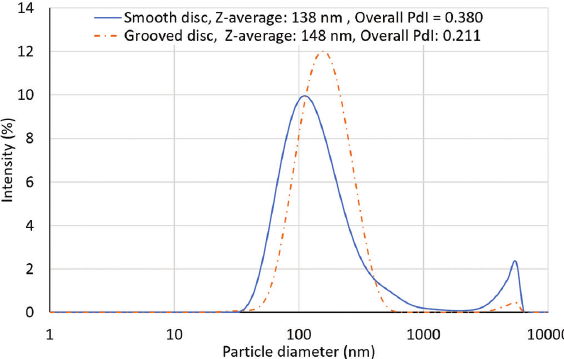
Figure 13: PSD comparing smooth and grooved disc surfaces at 18 mL/s, 9:1 ratio and 1200 rpm.